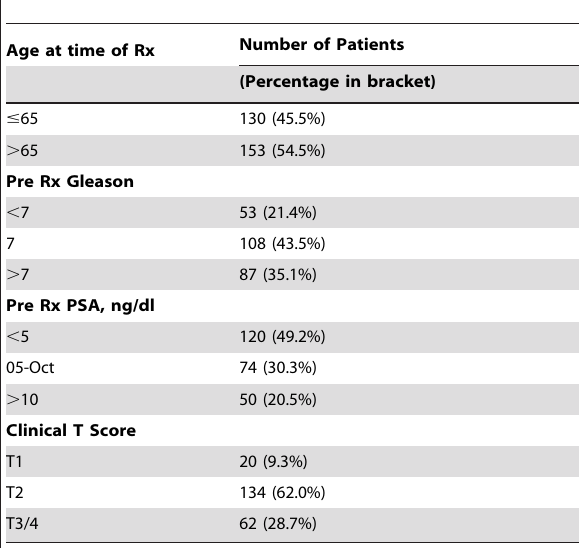
Table 1. Summary demographics of our series of patients who received SCT.